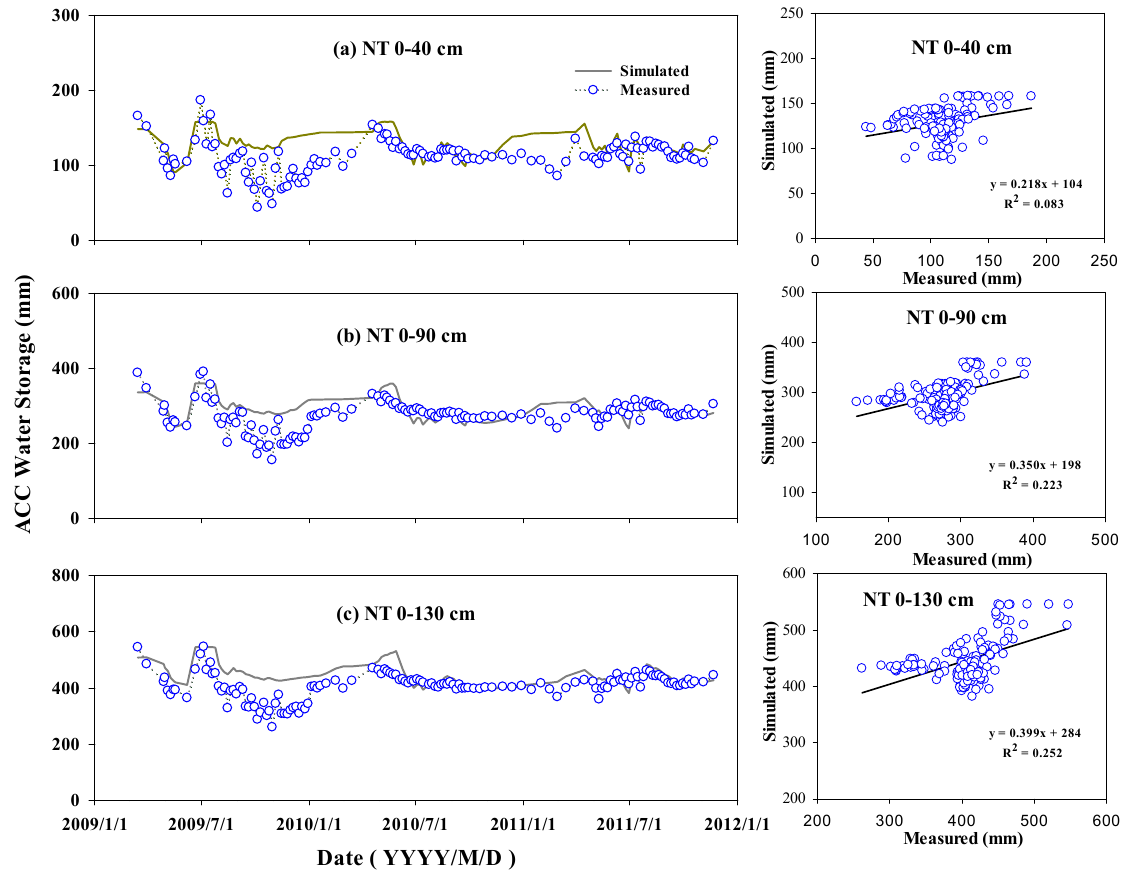
Figure 5. Simulations vs. measurements of water storage at ( a ) 0–40 cm, ( b ) 0–90 cm, and ( c ) 0–130 cm for NT during 2009–2011.